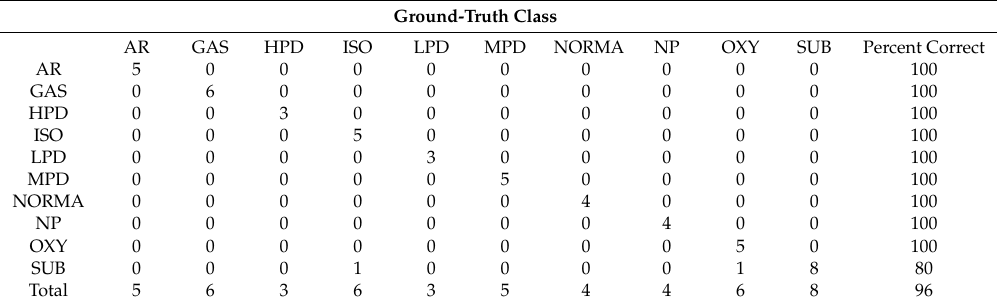
Table 2. Validation sample assignment